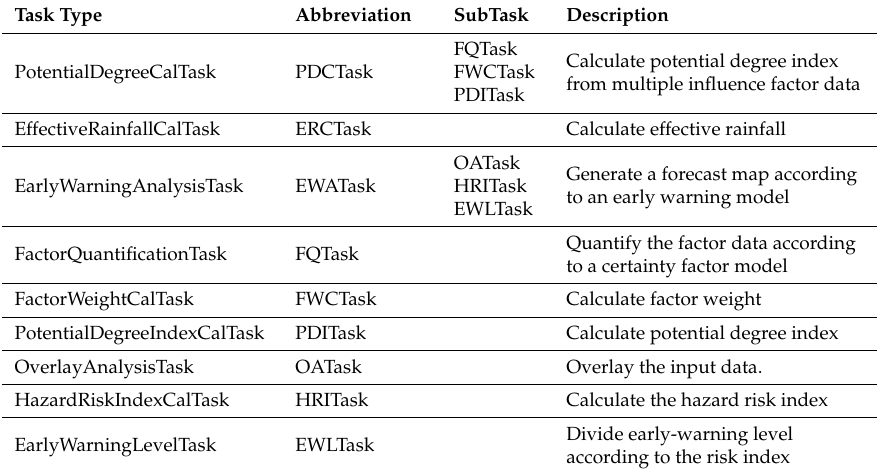
Table 1. Tasks involved in the MEW example